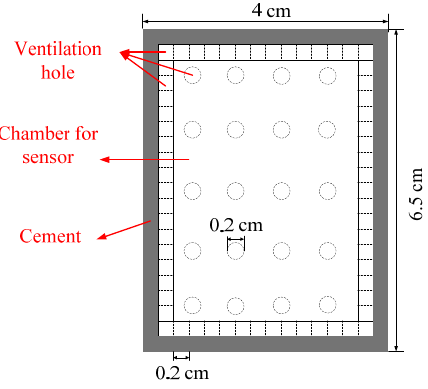
Figure 12. Top view of the proposed package box.